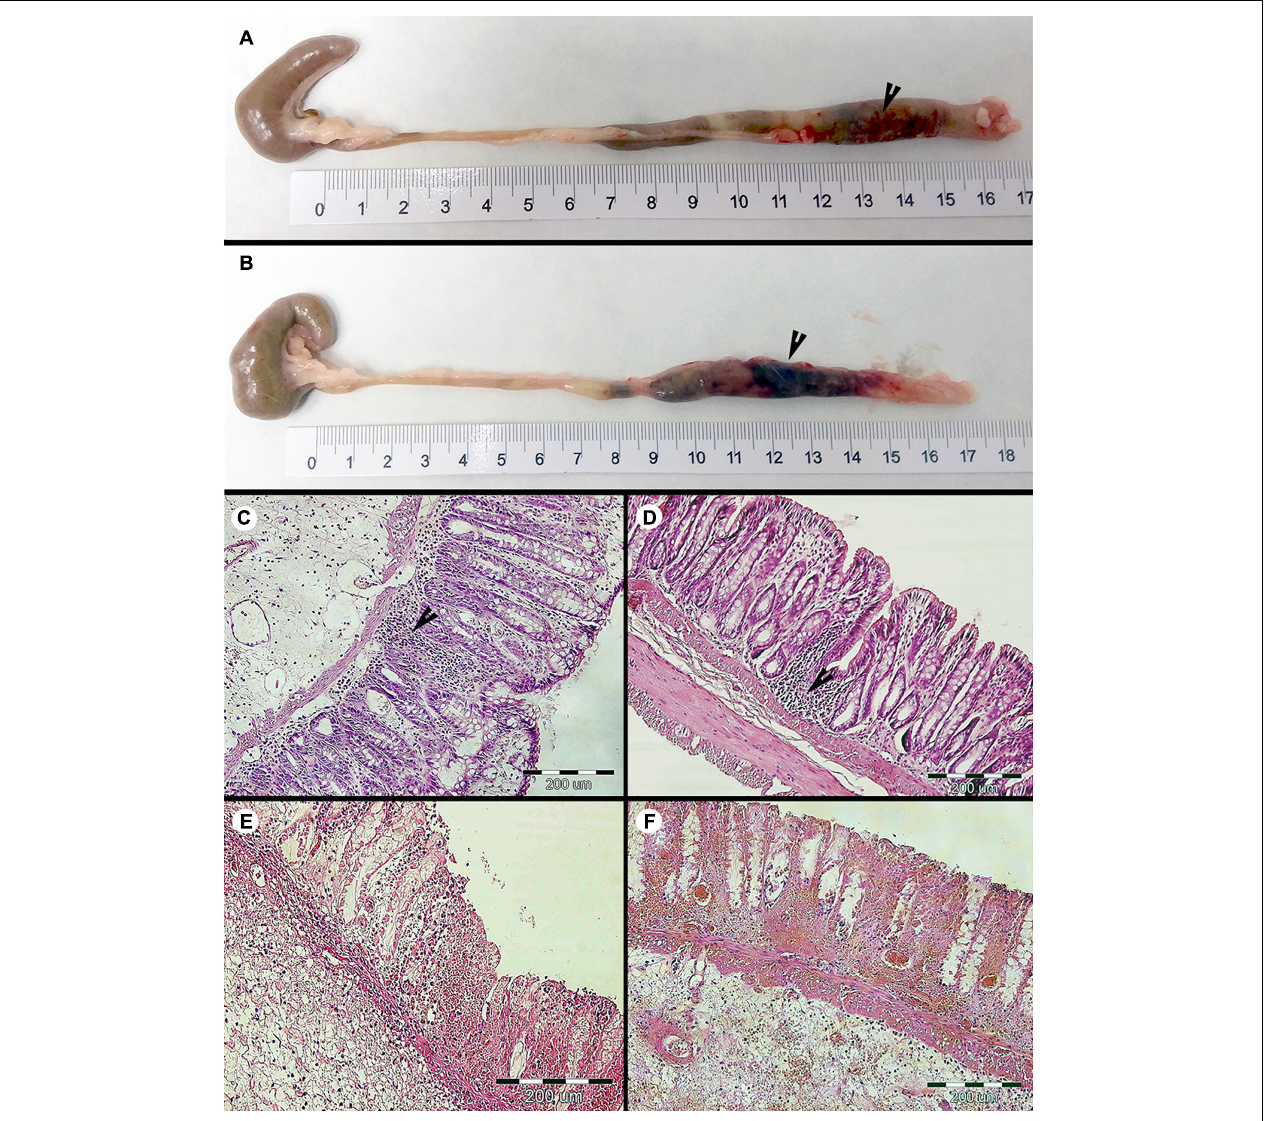
FIGURE 3 | Macroscopic and microscopic evaluation of the large intestine of the colonized and non-colonized rats after the DNBS moderate colitis during the short-term Blastocystis ST3 colonization (i.e., 3 weeks). (A) intestine of non-colonized rats with the colitis; (B) intestine of colonized rats with the colitis (black arrows indicate the inflammation in the large intestine). The histological cross sections of the rat large intestine after induction of colitis: (C,D) with inflammatory-cell infiltration – (C) non-colonized rats and (D) colonized rats (black arrows indicate inflammatory infiltrate in mucosa), and (E,F) foci with segmental mucosal necrosis – (E) non-colonized rats and (F) colonized rats. Histological examination was not conducted prior to colitis induction in the short-term experiment and macroscopically the intestine appeared healthy with the length in average 19